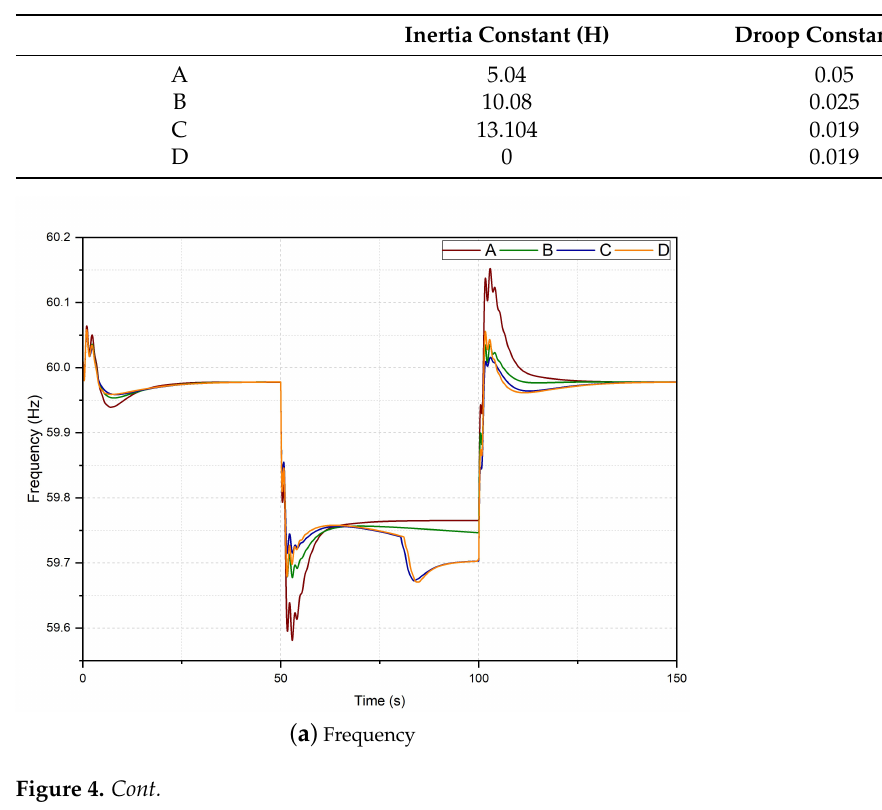
Table 3. Inertia and droop constant values for frequency control through WT.